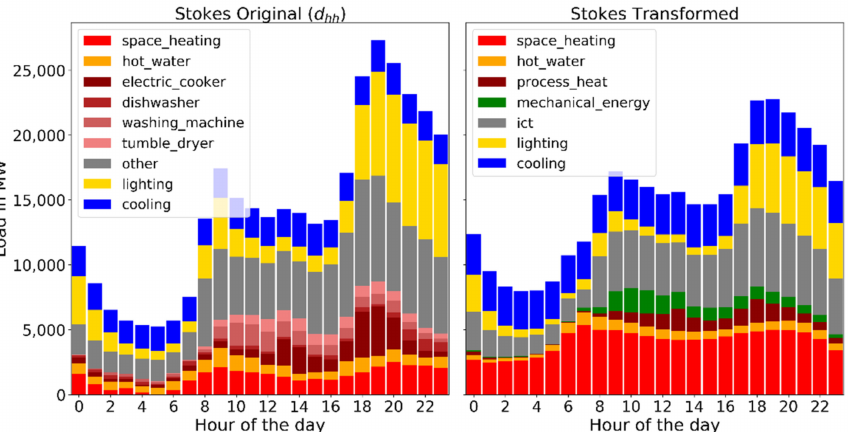
Figure 3. Stokes’ original load curve ( left ) vs. transformation to German Working Group on Energy Balances (AGEB) end-uses ( right ) for the average winter weekday (December–February) in the United Kingdom. The sum under both graphs is identical, but the contributions of some end-uses to the total load curve differ. Possible explanations for the shifts of consumption between end-uses might be that consumers’ behavior changed during the last 20 years or that the original measurements ( left ) were not representative for the whole United